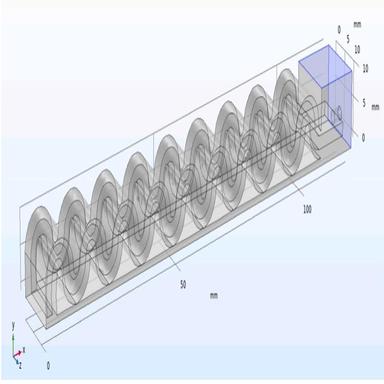
Fixed boundary constrains.